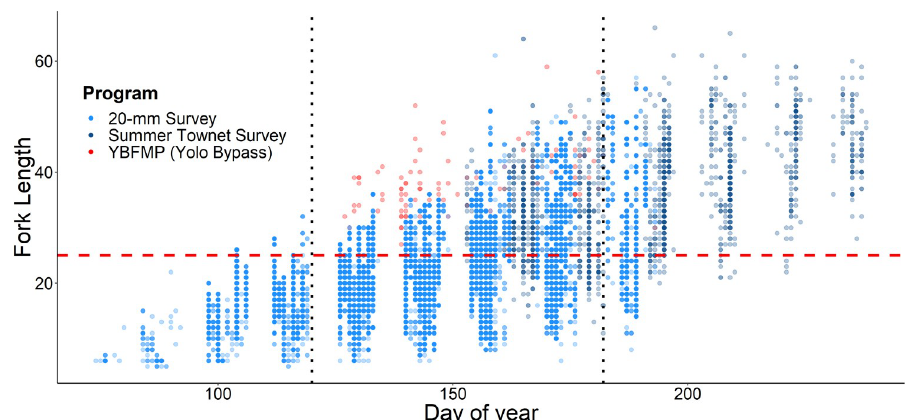
Fig 3. Comparison of juvenile Delta Smelt size between the Yolo Bypass (red) and elsewhere in the San Francisco Estuary (from 20-mm Larval Survey in light blue, from Summer Townet Survey in dark blue). Note that the YBFMP does not record fish with fork length under 25 mm. Red dashed line represents the 25 mm fork length lower limit cutoff for the YBFMP. Areas between the vertical black dotted lines represent the months of May and June, the months of focus for this